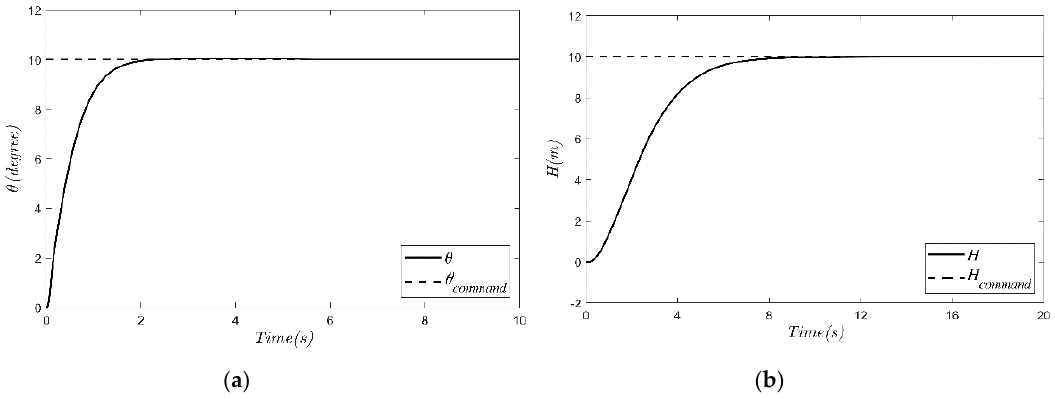
Figure 13. Simulation of pitch angle and altitude command tracking: ( a ) Pitch angle tracking. ( b ) Altitude tracking.